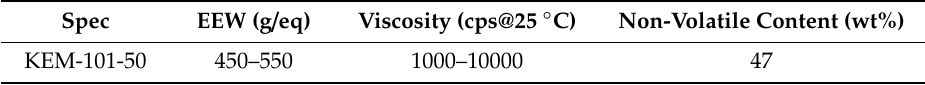
Table 2. Physical and Chemical Properties of the Epoxy Used in the Experiments.